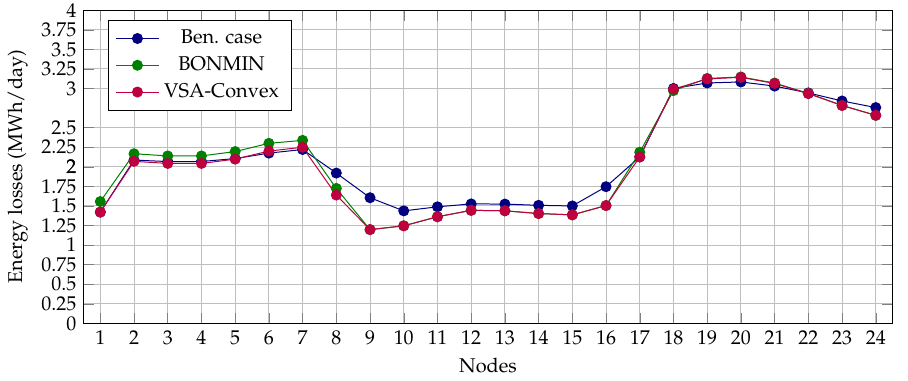
Figure 3. Output generation in terminals of the substation